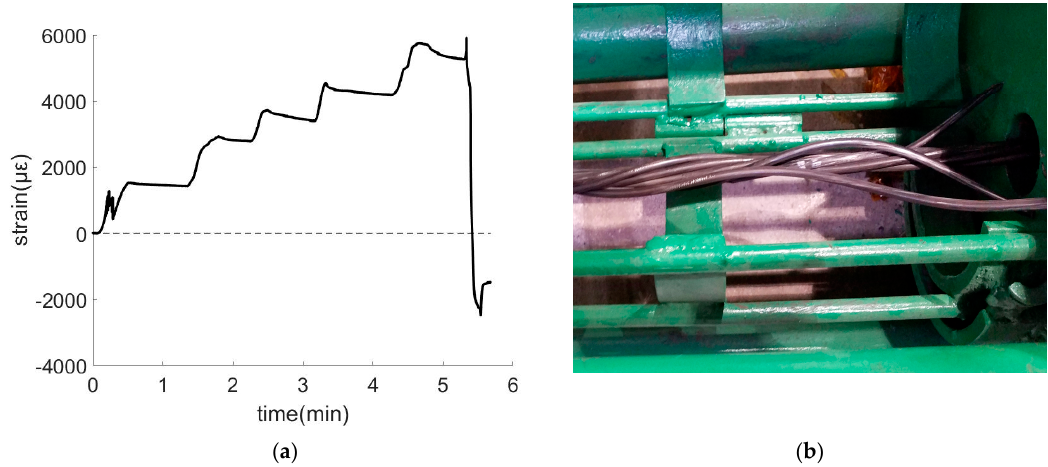
Figure 10. Sensing performance of prestressed smart composite cables in the fracture test: ( a ) strain-time curve in fracture test and ( b ) fracture form.